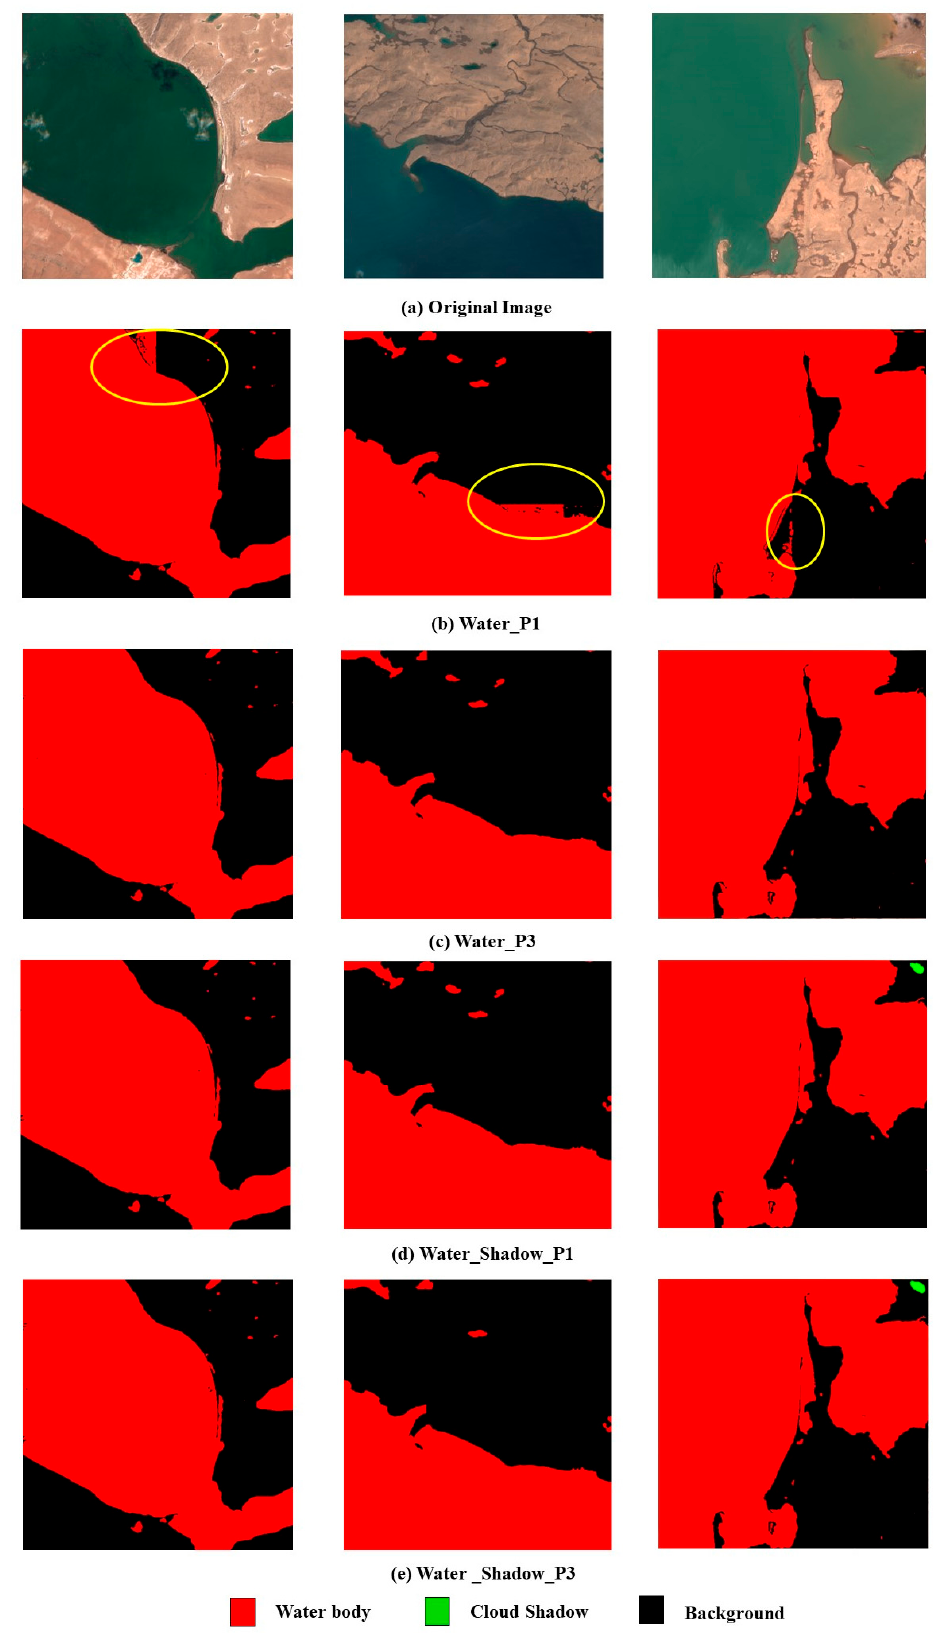
Figure 5. Results of water boundary extraction (The areas circled in yellow represent the noise points on the boundaries of water bodies).